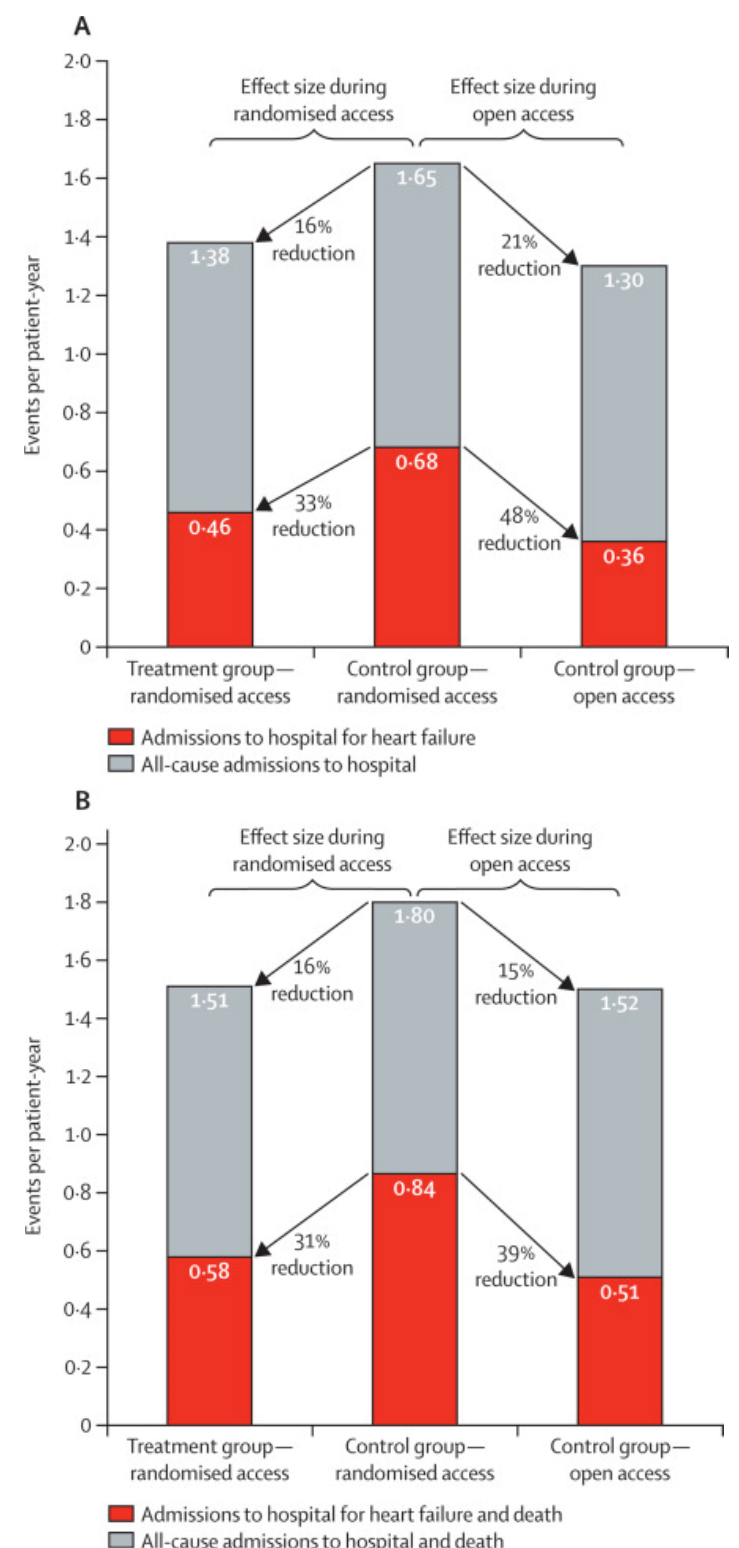
Figure 7. Effect of pulmonary artery pressure-guided heart failure management on ( A ) hospital admission rates and ( B ) on combined rates of hospital admissions and mortality. Reprinted from The Lancet, Volume 387, Issue 10017, Abraham et al., Sustained efficacy of pulmonary artery pressure to guide adjustment of chronic heart failure therapy: complete follow-up results from the CHAMPION randomised trial, Pages 453–461, Copyright 2016, with permission from Elsevier [25]. After the CHAMPION trial, several observational studies have investigated the ef- fects of CardioMEMS. A large retrospective study using Medicare data of approximately 1100 ambulatory NYHA III HF patients who had a CardioMEMS implanted, aimed to assess efficacy in a real-world setting. The rate of HF-related hospital admissions was compared between the 6-month time-period prior to CardioMEMS implantation and 6 months after implantation, and a risk reduction of 45% (HR 0.55, 95% CI 0.49–0.61) was found. Additional analyses in a subset of 480 patients showed a risk reduction of 34% (HR 0.66, 95% CI 0.57–0.76) after 12 months of follow-up [26]. Another cohort study used the Medicare claims database to identify 1087 CardioMEMS patients and matched these pa- tients to 1087 control patients by using the propensity score technique [27]. A significant difference in HF hospitalization rates was found in favor of the CardioMEMS cohort at 12 months post-implant (HR 0.76, 95% CI 0.65–0.89). Recently, two post-marketing surveillance studies have reported their findings. The US Post-Approval Study (PAS) and the CardioMEMS European Monitoring Study for Heart Failure (MEMS-HF) confirmed treatment benefits in reducing the number of HF